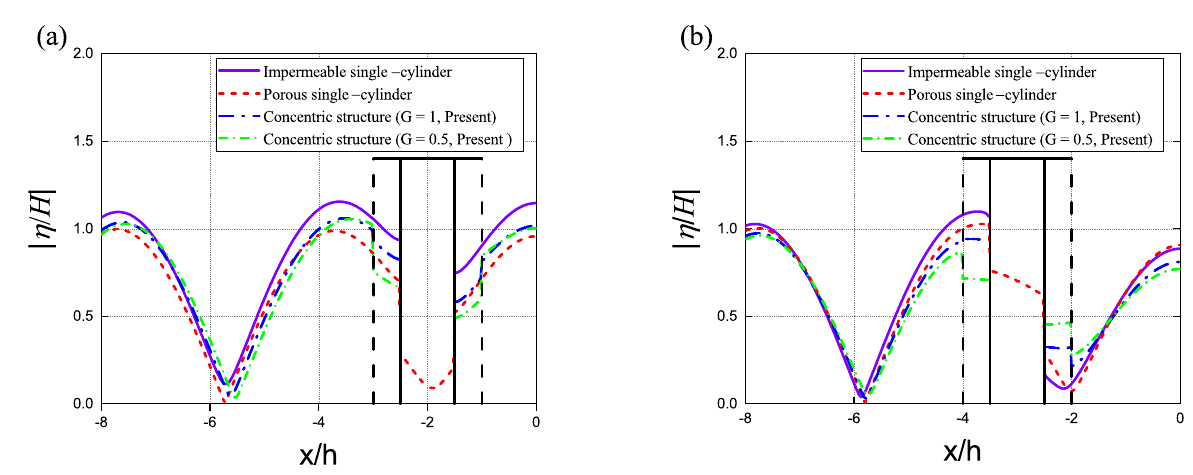
Figure 17. Comparison of free-surface elevation between single cylinder and the inner cylinder of the concentric system near a vertical wall with C w = 1.5, β = 0, h / a = 1.5 and c / a = 0.5: ( a ) e / a = 1 ( b ) e / a =